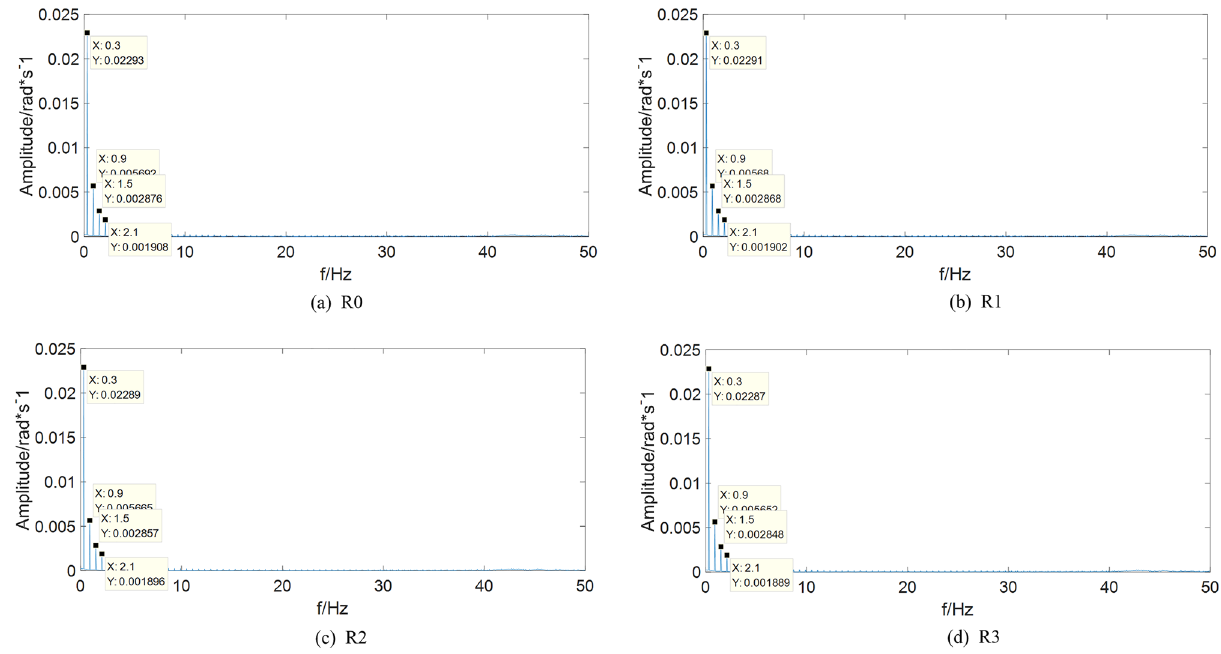
Figure 3. Frequency domain of output signal in different